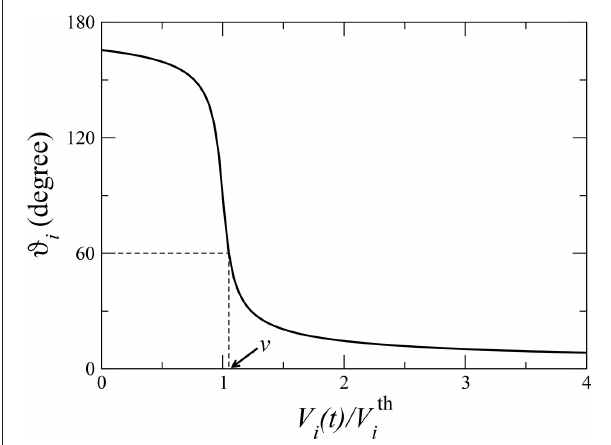
FIGURE 2 | Variation of the wetting angle ϑ i in the i th link given by G i ( t ) (Equation 4) as a function of the cumulative volume of water V i ( t ) (Equation 3) passed through that link. V th i is the water volume needed to reach the wetting angle to 90 ◦ in that pore. When there is a cut-off ( θ ) in the maximum change in the wetting angle, ϑ i is not allowed to change anymore as soon as ϑ i = θ . An example of a cut-off 60 ◦ is shown by dashed lines, in this case as soon as ϑ i = 60 ◦ or V i ( t ) = vV th i , ϑ i is not changed anymore. The time ( t ) needed to reach the cut-off value therefore varies from pore to pore and depends on the value of V th i